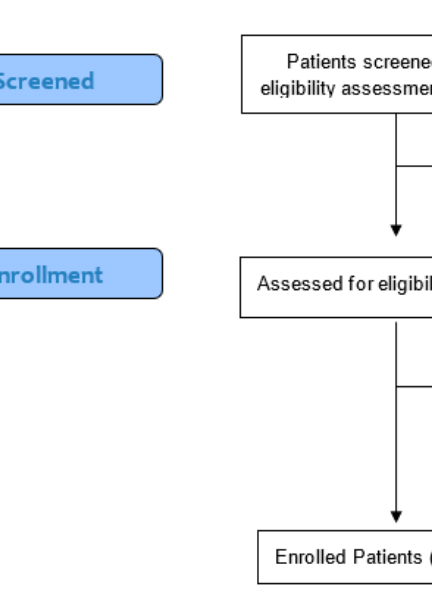
Figure 1. Flow chart of patients.